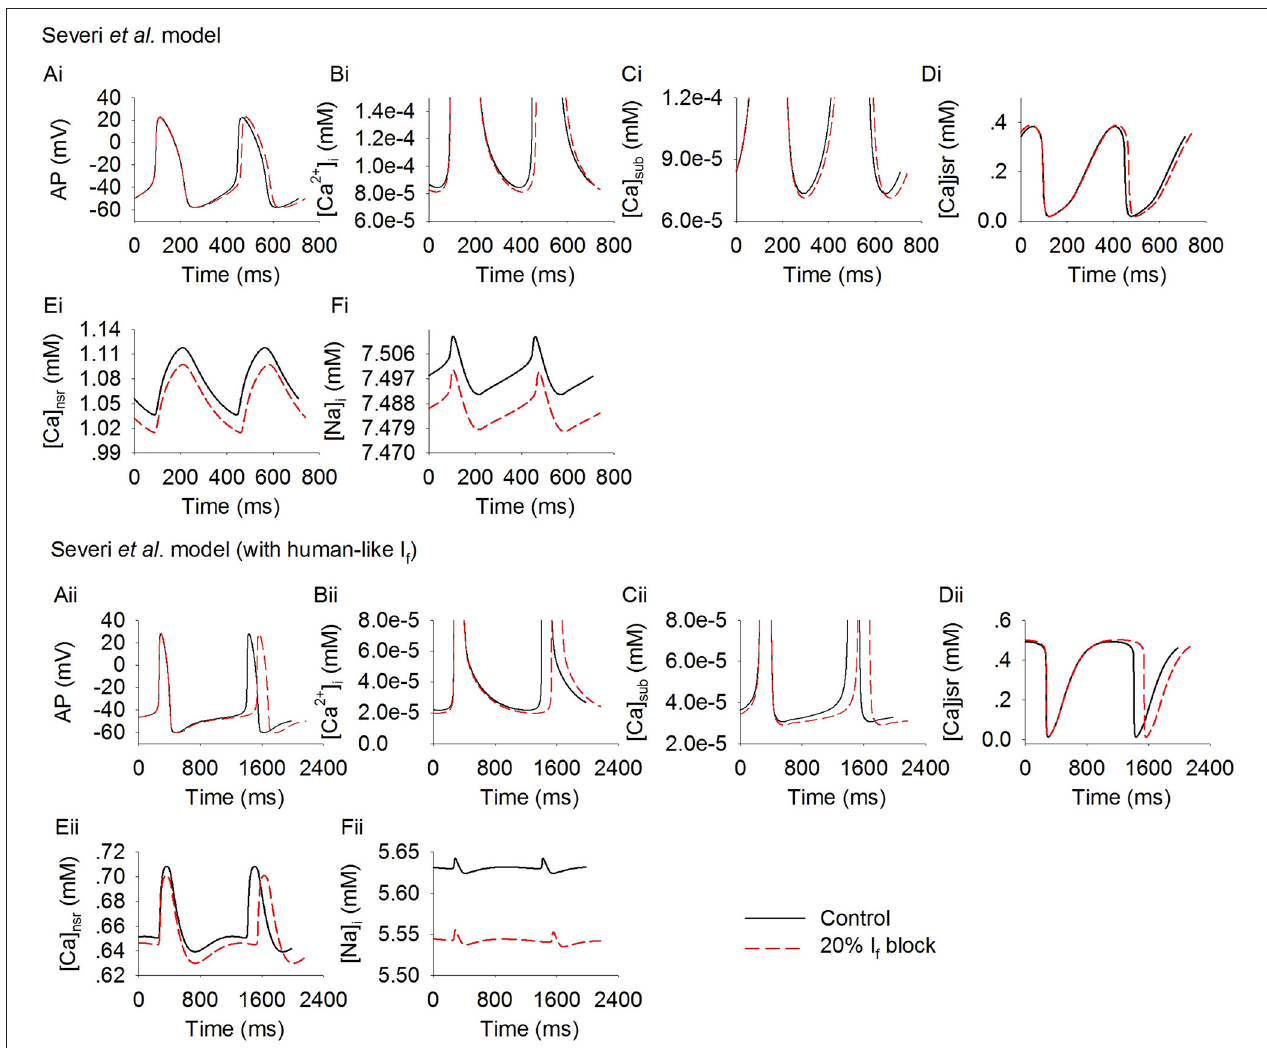
FIGURE 4 | Effect of I f block on the Ca 2 + transient in rabbit-like (Ai–Ei) and human-like (Aii–Eii) SAN cell models. (Ai,Aii) : the action potentials; (Bi,Bii) : Ca 2 + transient in the myoplasmic space; (Ci,Cii) : Ca 2 + transient in the myoplasmic sub-space; (Di,Dii) : Ca 2 + transients in the junctional SR; (Ei,Eii) : Ca 2 + transient in the network SR space; (Fi,Fii) : intracellular Na + concentration. Simulation results in control (solid line) are superimposed on those of I f blocking (dotted